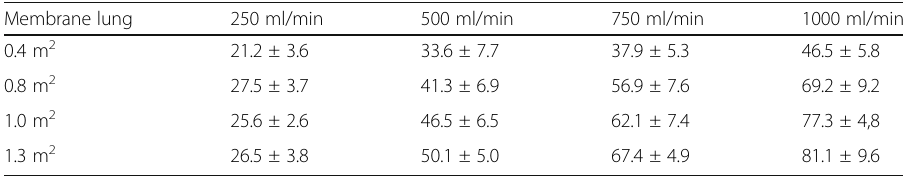
Table 3 Normalized extracorporeal CO 2 elimination Membrane